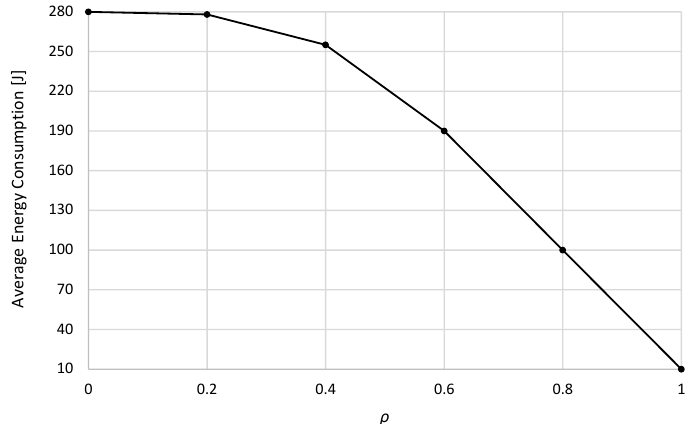
Figure 4. Average energy consumption against the value of ρ